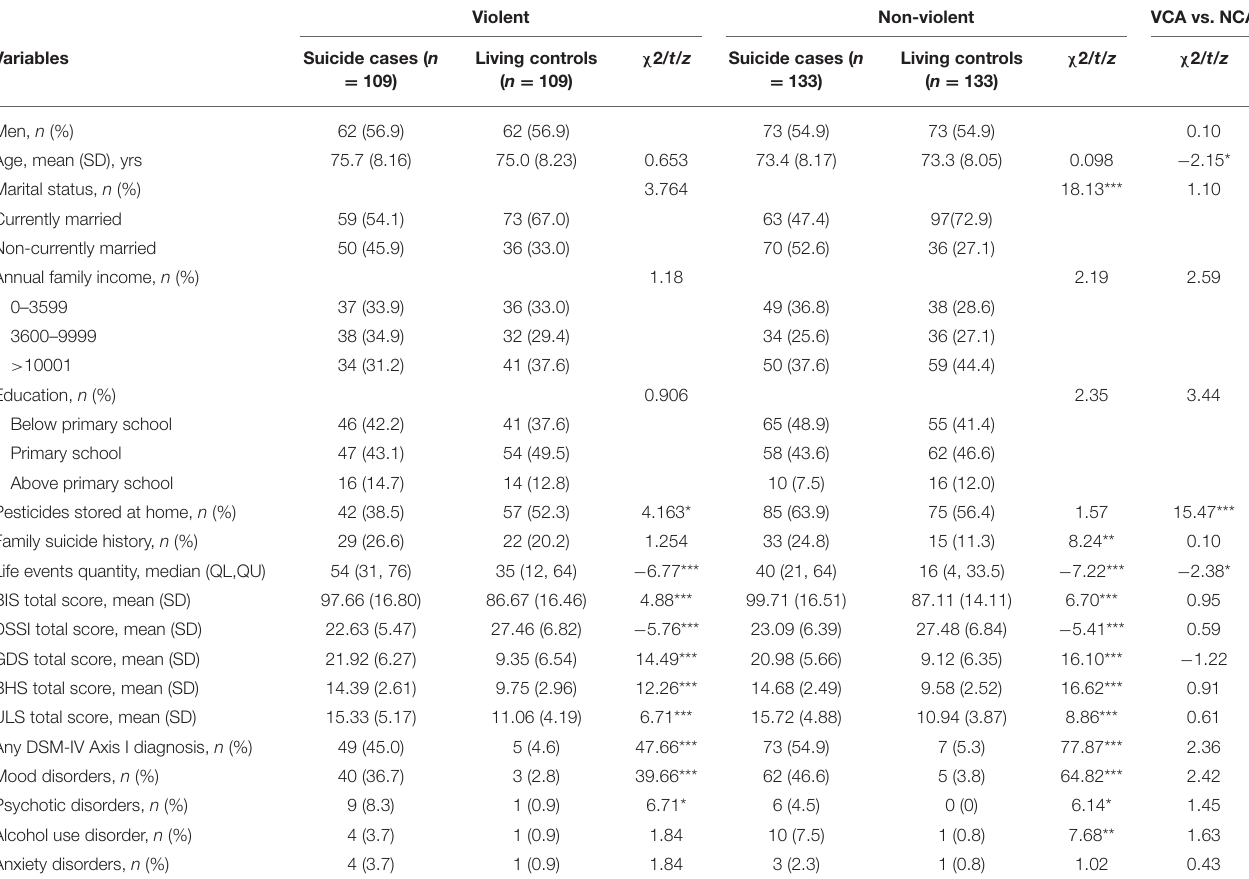
TABLE 1 | Comparison of sociodemographic, psychological, social environment, and life event characteristics of suicide cases and living controls.